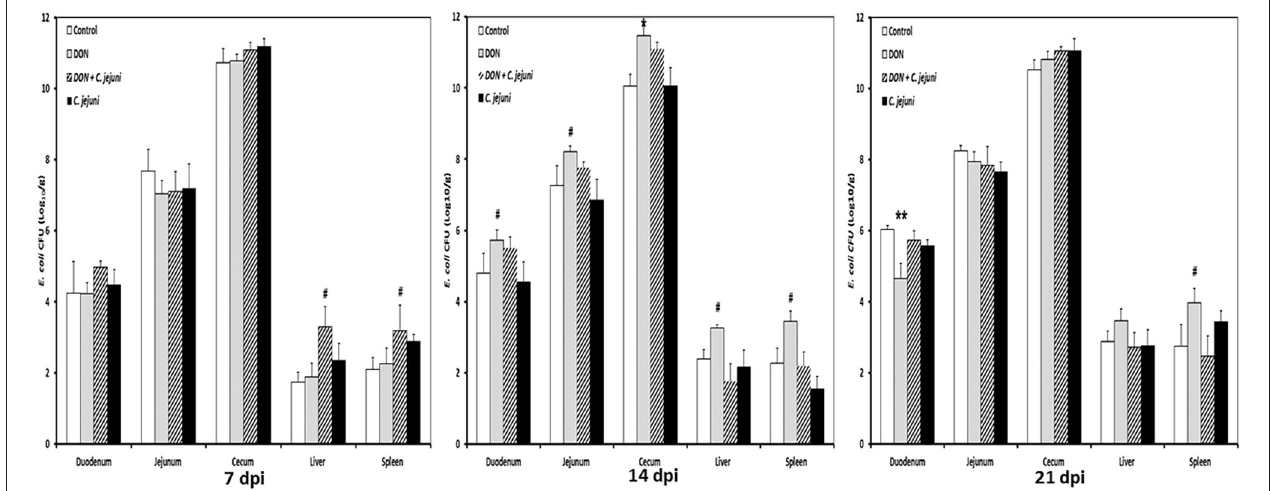
FIGURE 4 | E. coli counts at different time points post infection from duodenum, jejunum, cecum, liver, and spleen in birds fed with either control or DON contaminated diet with or without C. jejuni infection. Results are presented as mean values and SEM ( n = 5). Number of bacteria are expressed in logarithmic form of colony forming units (log CFU/g). Asterisks mark differences with # P ≤ 0.1, * P ≤ 0.05, or ** P ≤ 0.01.